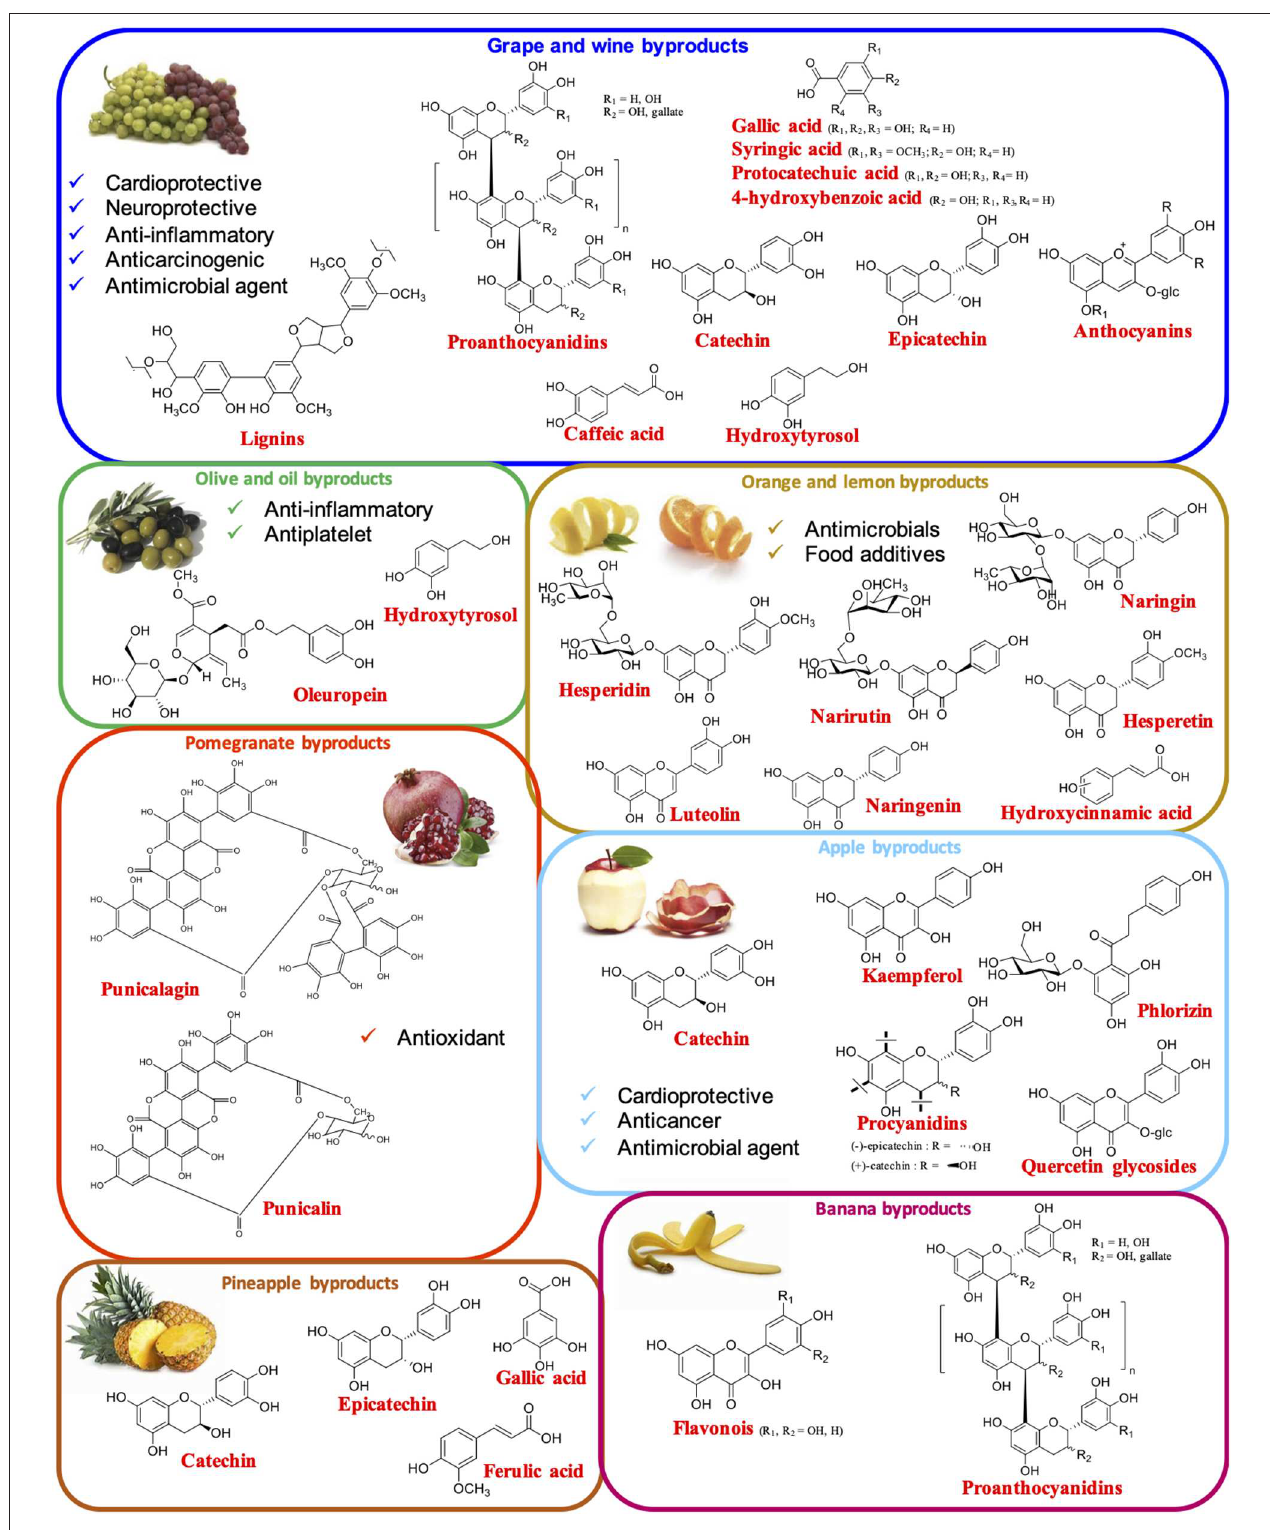
FIGURE 1 | Main fruit byproducts and their most prominent phenolic constituents with reported bioactivities.